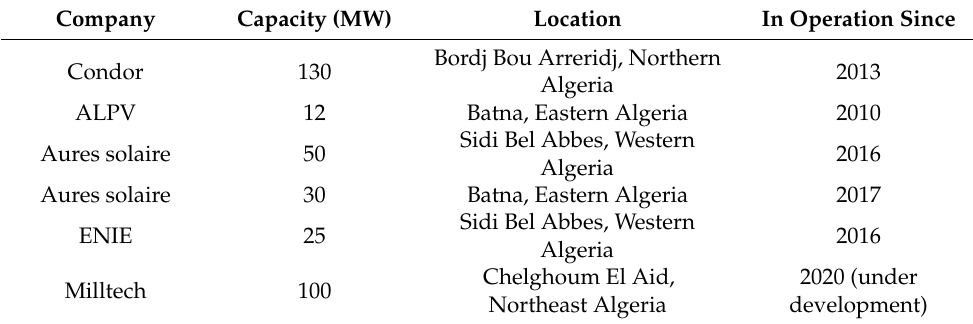
Table 8. PV factory locations in Algeria.